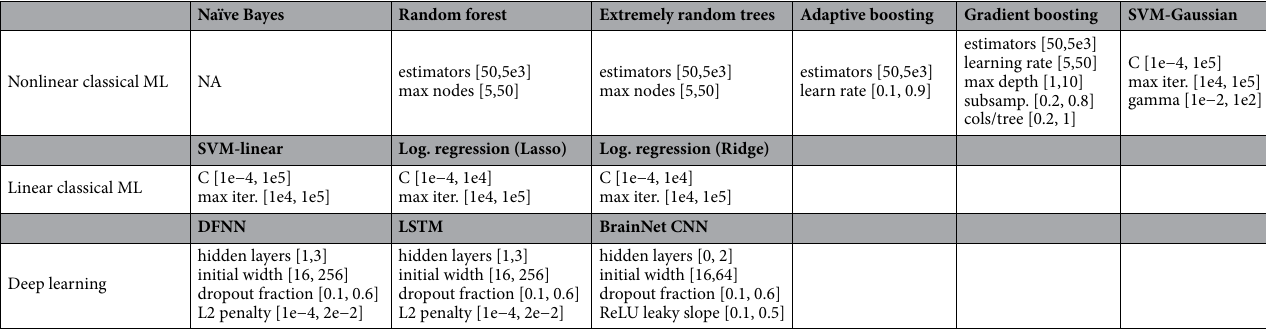
Table 4. Hyperparameter ranges for each machine learning model. Abbreviation definitions (in order of appearance from left to right): ML machine learning, learn rate learning rate, subsamp. subsampling per tree, cols/tree columns per tree, max iter. maximum iterations, SVM support vector machine, SVM-Gaussian SVM with Gaussian radial basis function kernel, SVM-Linear SVM with linear kernel, Log. Regression logistic regression, lasso lasso regression with L1 penalization, ridge ridge regression with L2 regularization, DFNN deep feedforward neural network, LSTM bidirectional long short term memory neural network, BrainNet CNN BrainNet convolutional network 52 , ReLU leaky slope rectified linear activation unit slope for x <